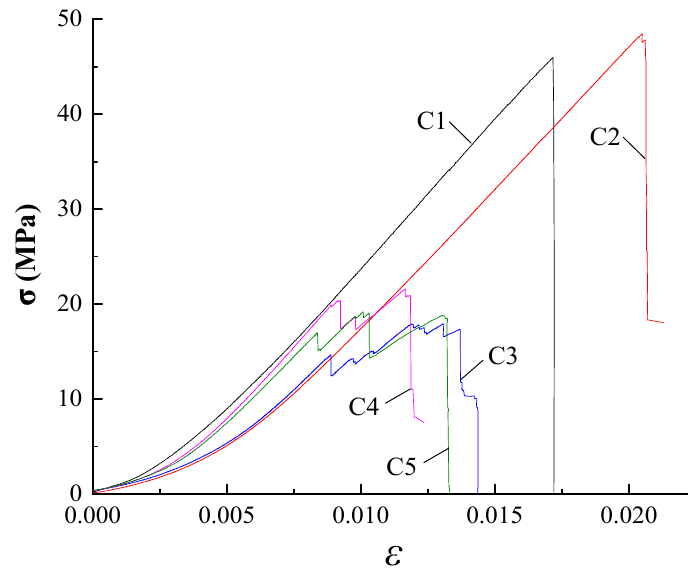
Figure 7. Uniaxial compression stress–strain curves and failure modes of five samples from the Tashan coal mine, Shanxi Province, China.